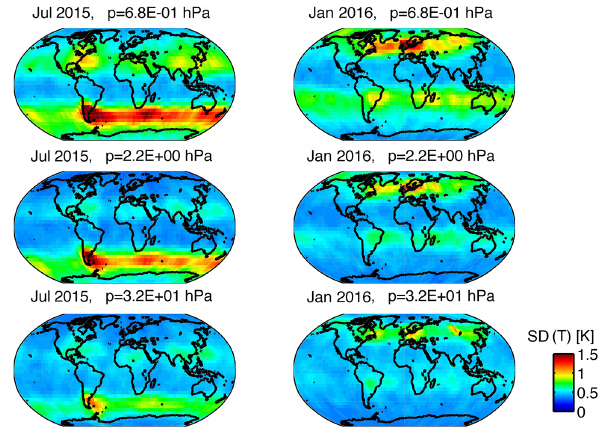
Figure 6. Global maps of inertia-gravity wave activity at various pressure levels in the stratosphere and the stratopause region. Please note that the temperature scale is different than in Fig. 5. SD( T ) can be regarded as the mean amplitude of the inertia-gravity